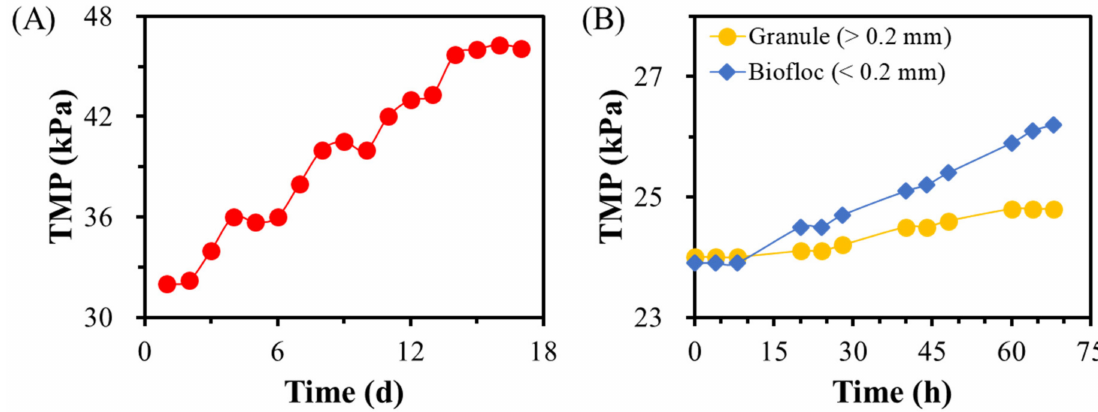
Figure 10. TMP profile of the membrane inserted in the mixed liquor of GMBR within a backwash cycle ( A ), and TMP profile of the membrane when only bioflocs or granules were loaded in the GMBR, respectively ( B